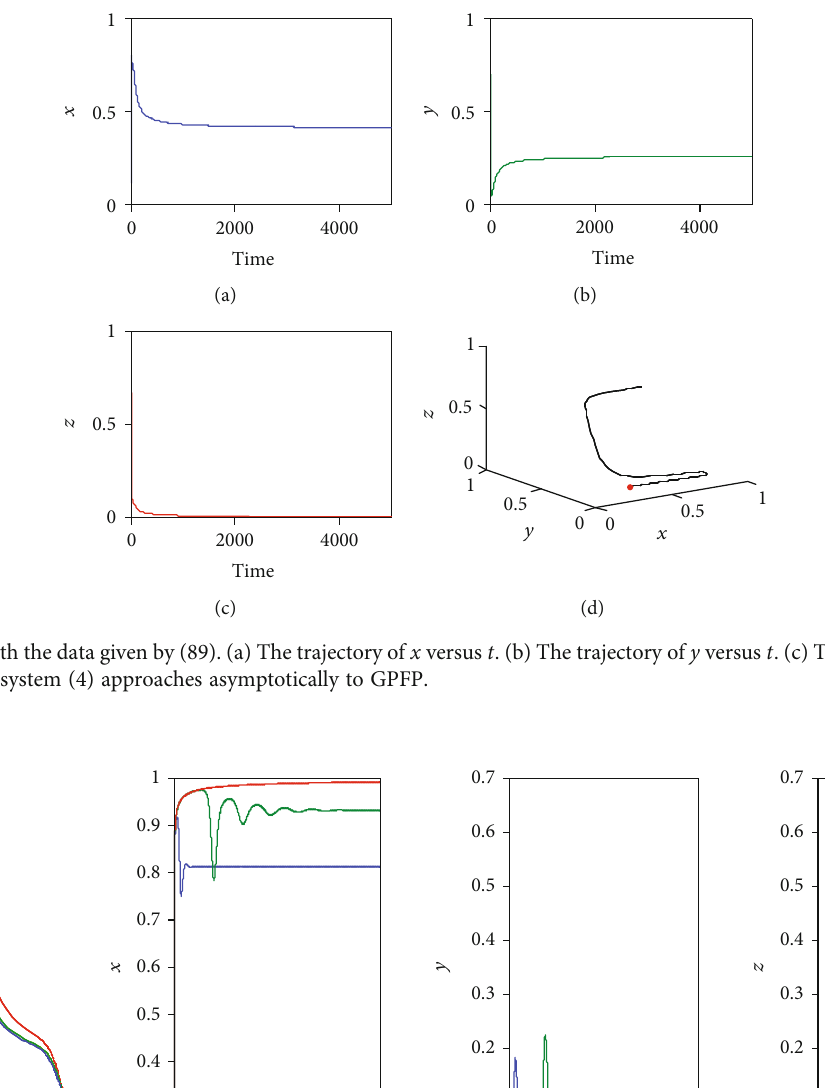
Figure 3: (a) The trajectories of system (4) for the parameters given by (89) with di ff erent values of α colors blue, green, and red, respectively, approach asymptotically to CP for the fi rst two values, while the trajectory approaches to SPFP for the third value. (b) The trajectories of x versus t . (c) The trajectories of y versus t . (d) The trajectories of z versus t